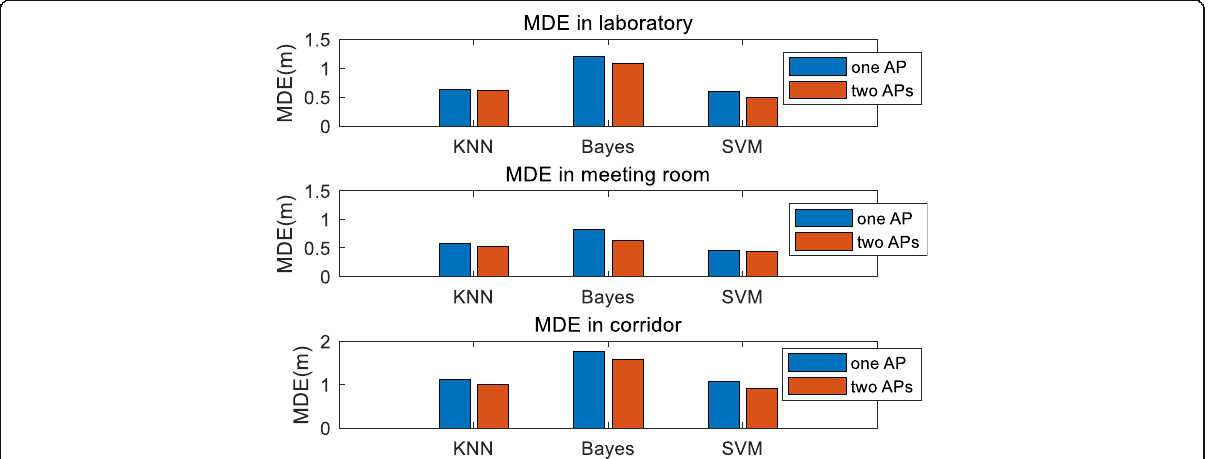
Fig. 10 MDE for different number of APs. In the top figure, blue and orange represent the median distance error of different match algorithm under the one AP and two APs conditions in the laboratory, respectively. In the middle figure, blue and orange represent the median distance error of different match algorithm under the one AP and two APs conditions in the meeting room, respectively. In the bottom figure, blue and orange represent the median distance error of different match algorithm under the one AP and two APs conditions in the corridor, respectively